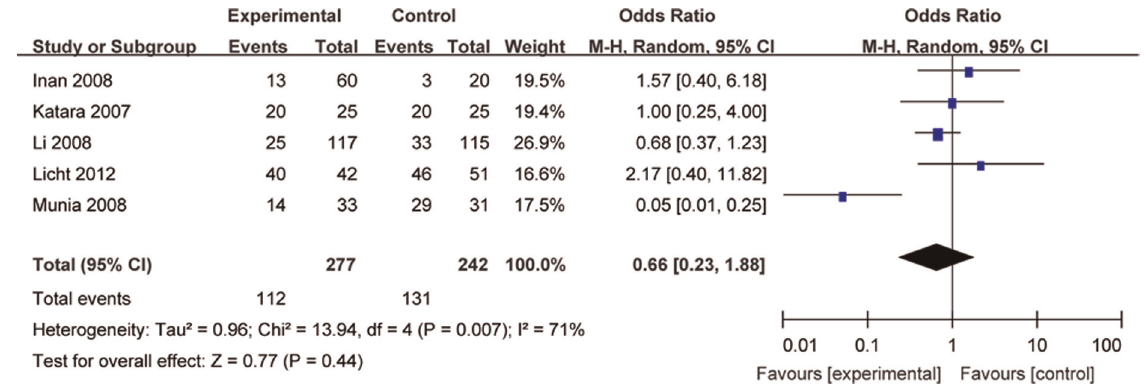
Figure 2 - CS after restricting the level of sympathectomy. CI, confidence interval; CS, compensatory sweating.